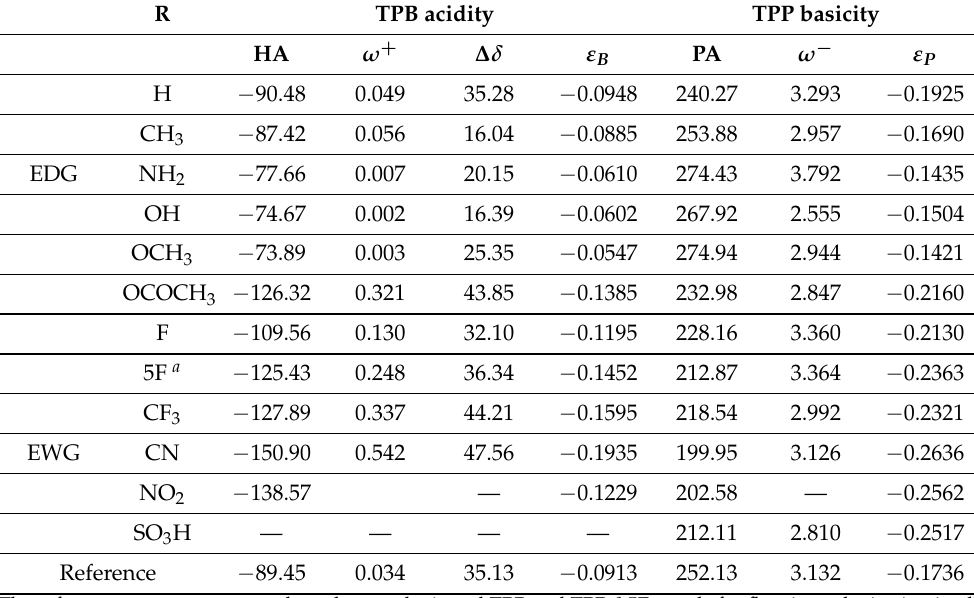
Table 1. Acidity of triphenylborane (TPB) and basicity of triphenylphosphine (TPP) substituted with electron-donating (EDG) and electron withdrawing (EWG) groups (R). Acidity is estimated by hydride affinity (HA), in kcal/mol, electroaccepting power ( ω + ), in eV, variation of the 31 P NMR chemical shift ( ∆ δ ), in ppm and boron empty orbital energy ( ε B ), in a.u. Basicity is estimated by proton affinity (PA), in kcal/mol, electrodonating power ( ω − ), in eV and phosphorus lone-pair orbital energy ( ε P ), in a.u. R TPB acidity TPP basicity HA ω + ∆ δ ε B PA ω − ε P H − 90.48